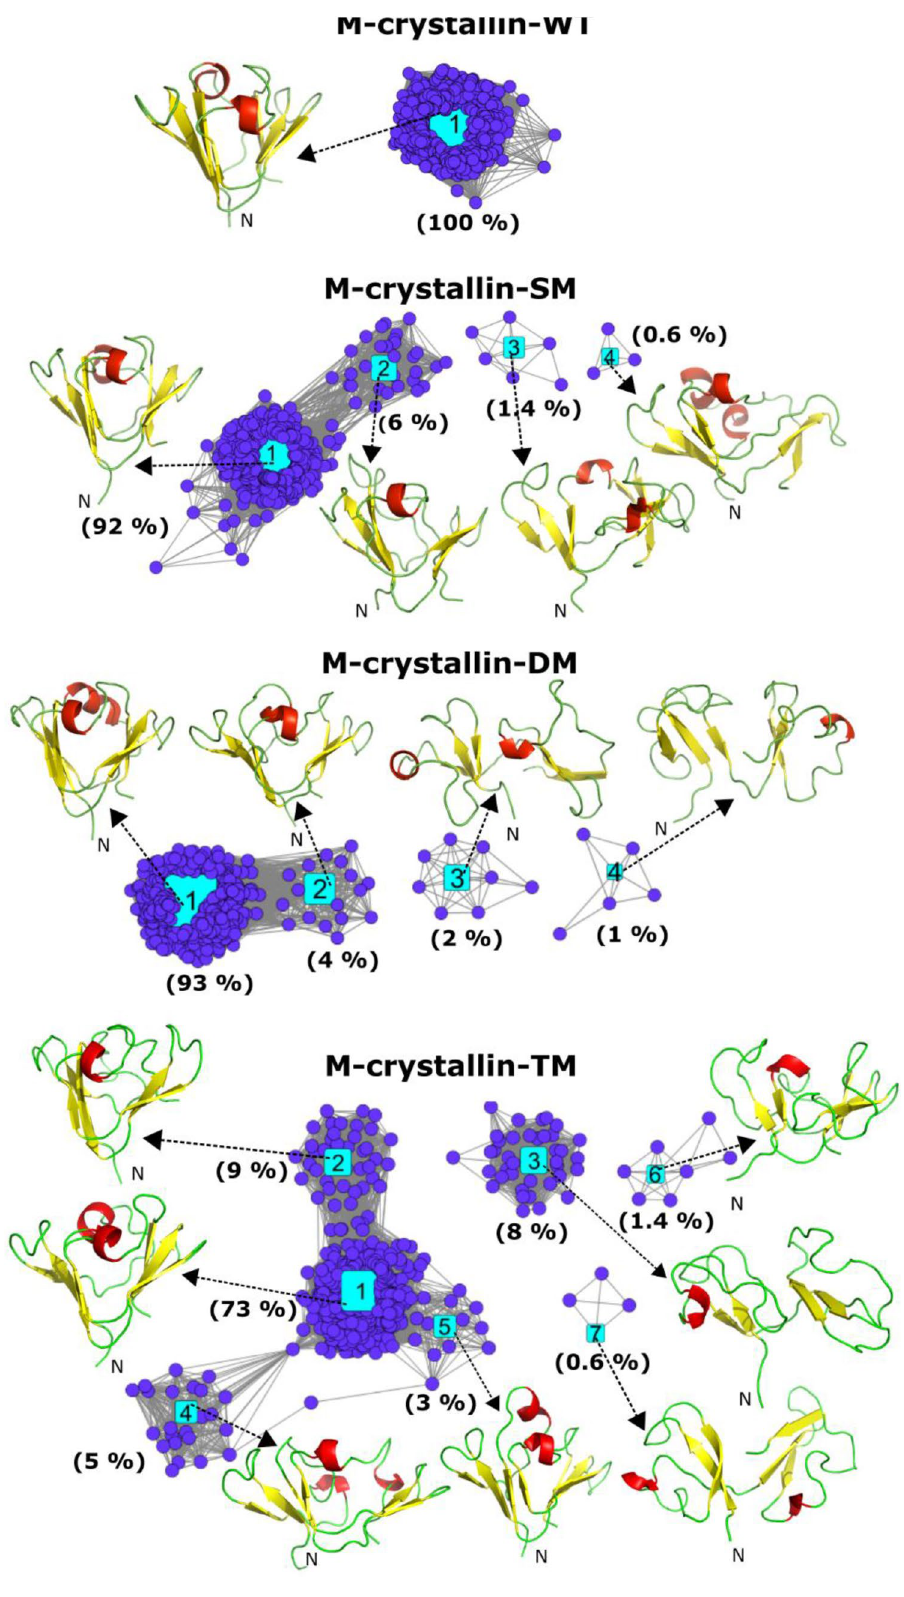
Figure 2. Network cluster layouts of M-crystallin wild type and its mutants. An identical pairwise C α RMSD cut-off of 3.5 Å was used for constructing these network layouts. Five hundred frames were taken at a regular interval from the equilibrated region (70–200 ns) of each simulations for this analysis. A centroid structure corresponding to each cluster is pointed by an arrow. Cytoscape version 3.5.1 55 (https:// cytos cape. org/) is used to build network